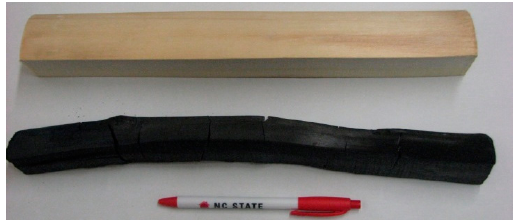
Figure 4. Comparison of oven-dried yellow poplar biomass ( top ) to the charcoal produced ( bottom ).